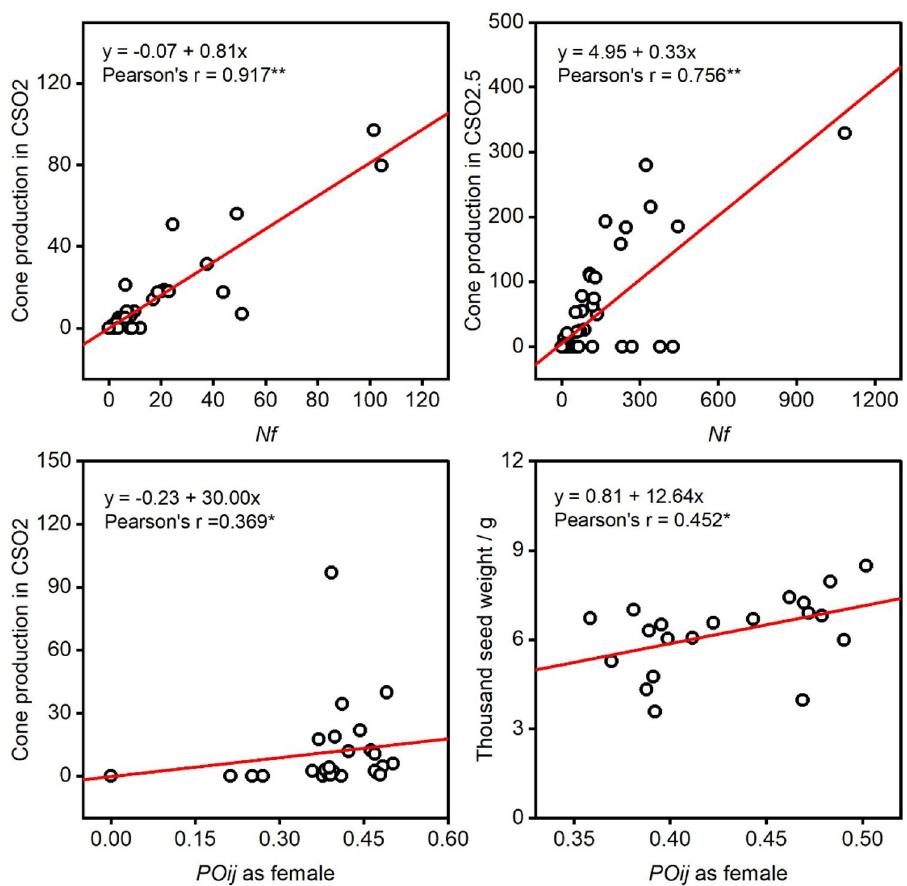
Figure 6. Regression between seed/cone characteristics and number of female strobili ( Nf ), synchronization index in seed orchards. * and ** indicate significant difference at the level of 0.05 and 0.01,